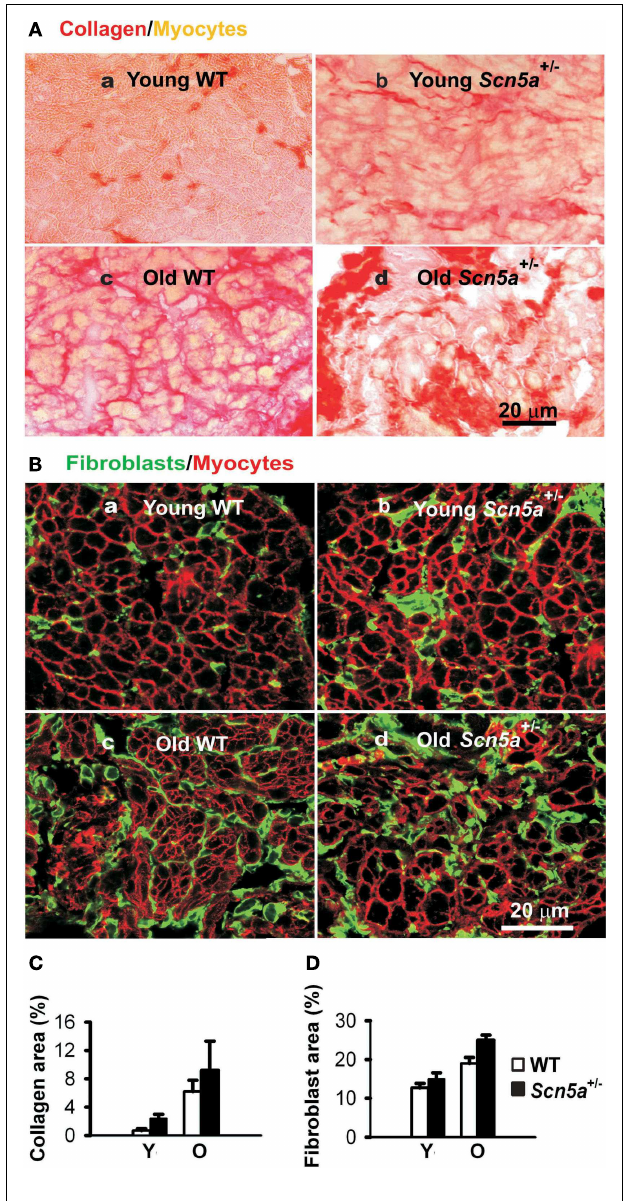
FIGURE 2 | Characterization of remodeling of extracellular matrix in the SAN. (A) Picosirus red collagen staining in SAN section from each of four groups of mice. (B) Vimentin immunostaining for fibroblasts in SAN tissue sections. (C) Collage quantification: area of picosirus red-stained tissue expressed as a percentage of the field of view. (D) Fibroblast quantification with area of vimentin staining expressed as a percentage of the field of view.Y, young mice; O, old mice.Two-way ANOVA: P < 0.05, Scn5a + / − vs.WT mice; P < 0.001, young vs. old